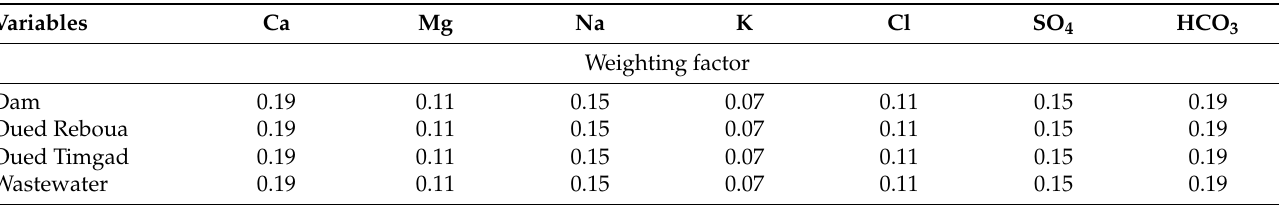
Table 6. Results of NSFWQI for water quality of stations.